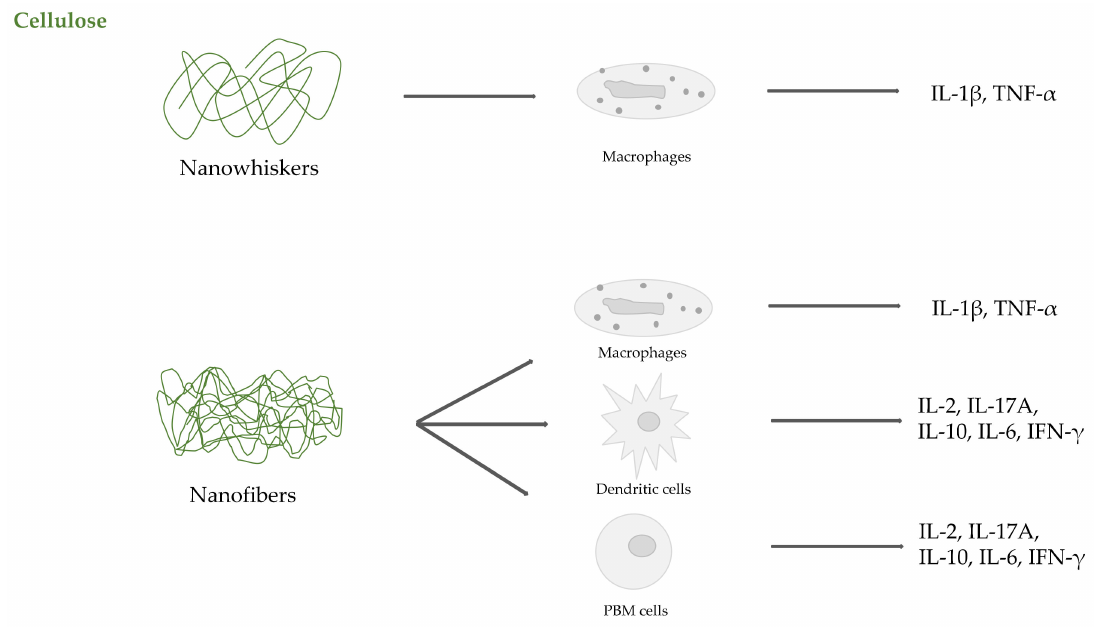
Figure 4. Cytokine release induced by cellulose